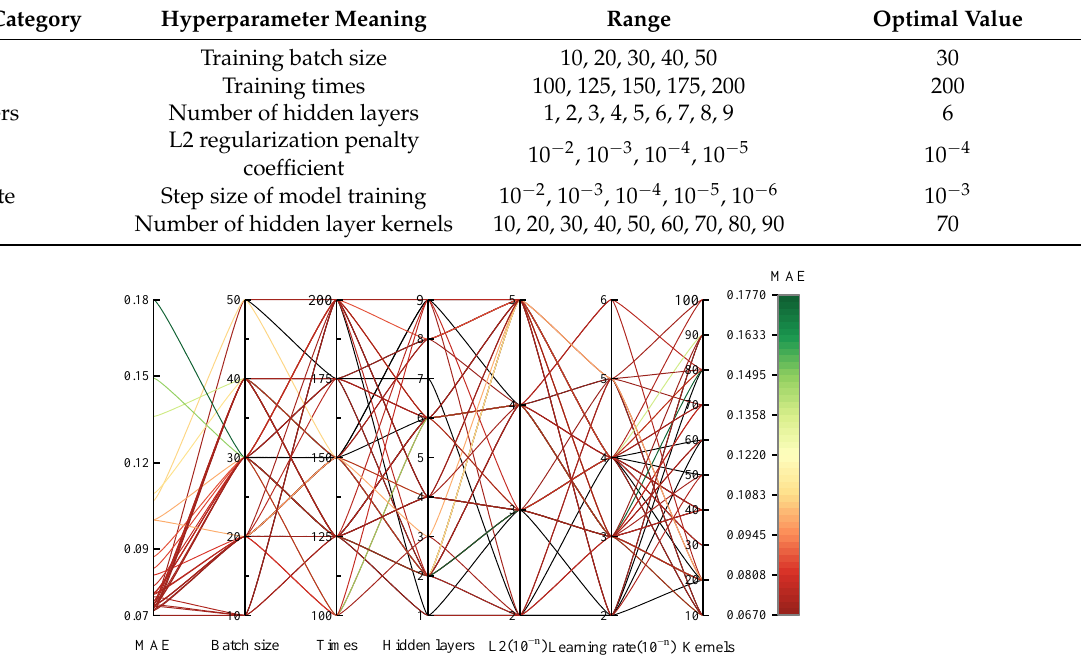
Table 3. Optimized hyperparameter types, meanings, ranges and optimal values of DNN.